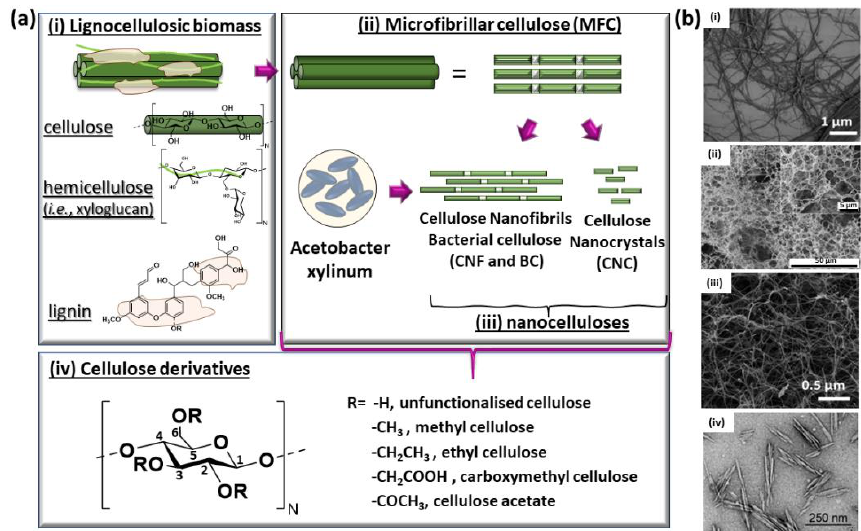
Figure 2. ( a ) Schematic representation of (i) the components of lignocellulosic biomass in plant cell wall (PCW) divided in cellulose, hemicelluloses and lignin, (ii) microfibrillated cellulose (MFC), (iii) nanocelluloses and (iv) cellulose derivatives. ( b ) Scanning electron microscopy (SEM) or transmission electron microscopy (TEM) images illustrating the morphology of different cellulose forms: (i) SEM of microfibrillated cellulose (MFC) [30], (ii) SEM of cellulose nanofibrils (CNFs) [30], (iii) SEM of bacterial cellulose (BC) [30] and (iv) TEM of cellulose nanocrystals (CNC) from cotton [36]. Copyrights: all images have been adapted and reproduced with permission from: ( b ) (i – iii) © The Royal Society of Chemistry 2020, (iv) © The Royal Society of Chemistry 2010.